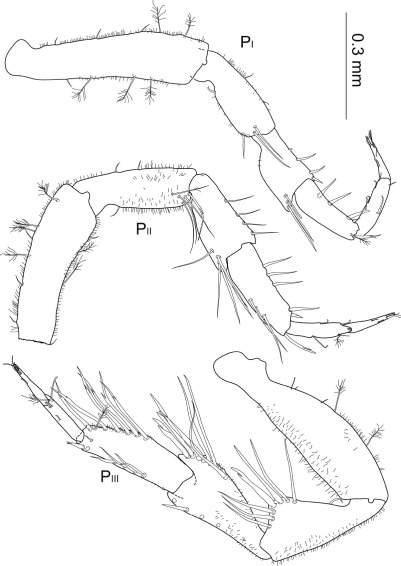
Macrostylis antennamagna sp. n. (Paratype ♀, ZMH (K-42169)) pereopods 1–3 (PI–PIII), pereopod 2 basis broken off.